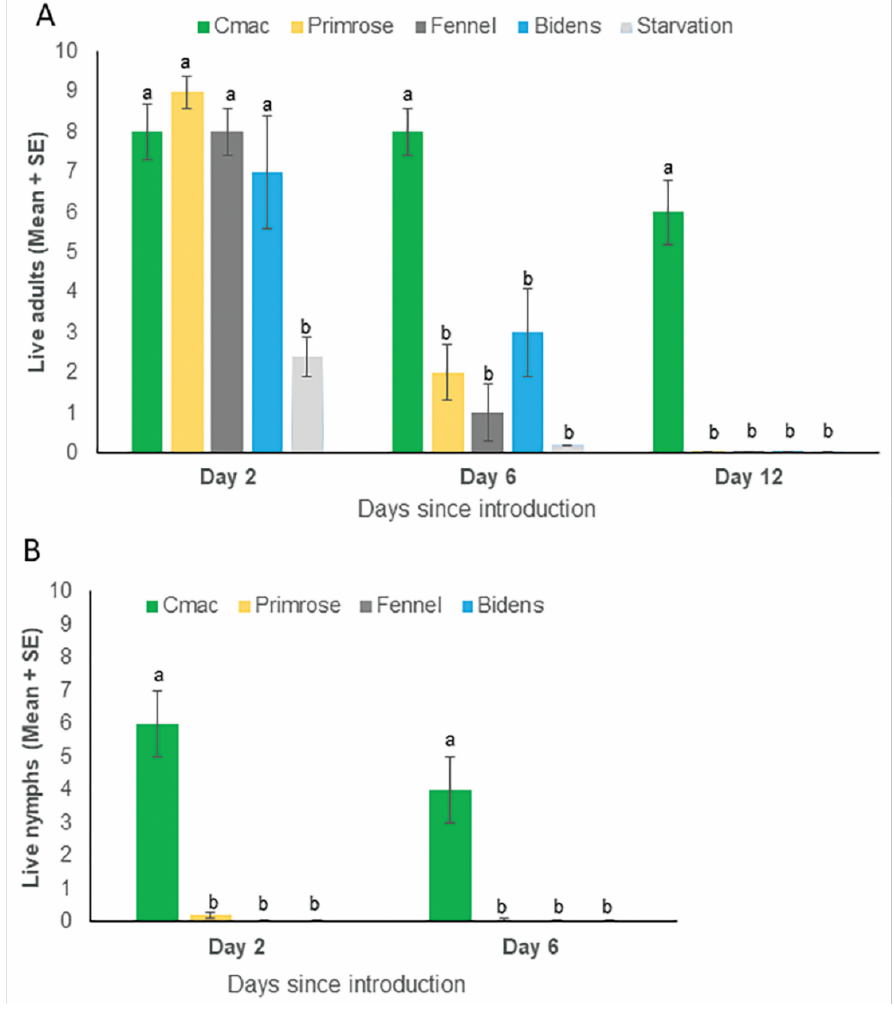
Figure 5. Bar graph showing the survival of Diaphrina citri adults ( A ) and nymphal ( B ) instars (means ± SEM) on individual plants of four di ff erent plant species (Primrose, Dogfennel, Spanish needle, and Citrus macrophylla ) and starved control 2, 6, and 12 days after introduction onto plants in clip cages. ( A ) Live adult psyllids on plants and starved control after 2, 6, and 12 days. ( B ) Live fourth instar nymphs on plants after 2 and 6 days. Means analyzed by one-way ANOVA followed by Tukey’s HSD. Treatments having no letters in common are significantly di ff erent ( α = 0.05) (n =